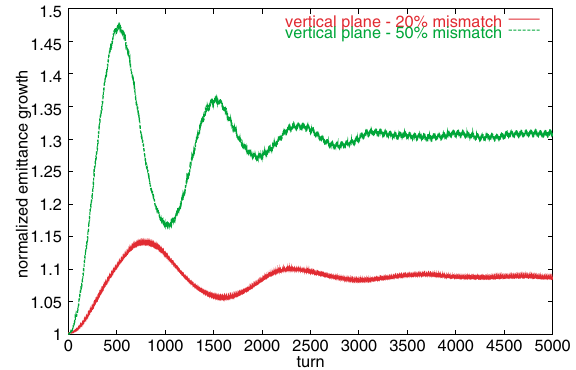
FIG. 6. (Color) The vertical normalized emittance growth of the weak beam with an initial 20% and 50% mismatch of the strong beam and 0.002 lower machine tune of the weak